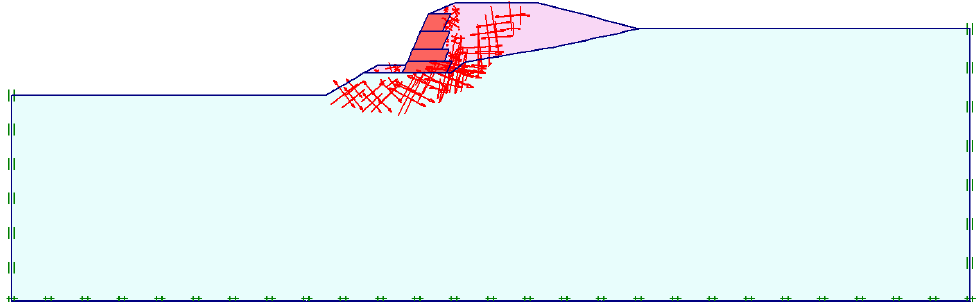
Figure 4. Total strain at failure calculated for the case of homogeneous foundation soils (c ′ 1 = 10 kPa and φ′ 1 = 30°) by means of the phi-c reduction stage. The length and the direction of the arrows represent the intensity and the direction, respectively, of the principal strains. The concentration of the strains identifies a global failure mechanism.